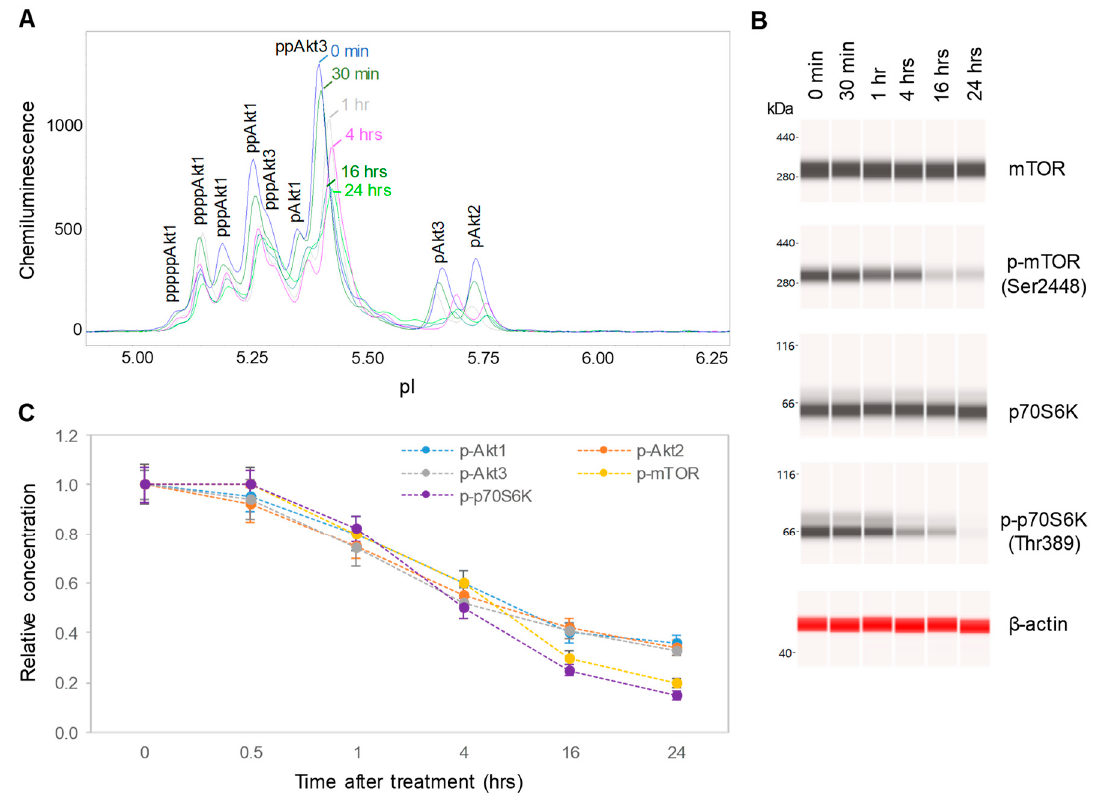
Figure 5. Time-dependent negative regulation of the pI3K/Akt/mTOR signaling pathway by a CBD oil. ( A ) The pan-Akt profiles of SH-SY5Y cells as a function of time after treatment with CBD oil V1; ( B ) the expression levels of mTOR and p70S6K phosphoisoforms as a function of time after treatment with CBD oil V1; ( C ) the relative concentrations of Akt, mTOR, and p70S6K phosphoisoforms as a function of time after treatment with CBD oil V1. Relative concentration describes fold change of protein phosphoisoforms after treatment as compared with the control. Error bars are the standard deviations of six repeated measurements per experimental condition. SH-SY5Y cells were treated with CBD oil V1 at 100 µg/mL final CBD concentration.